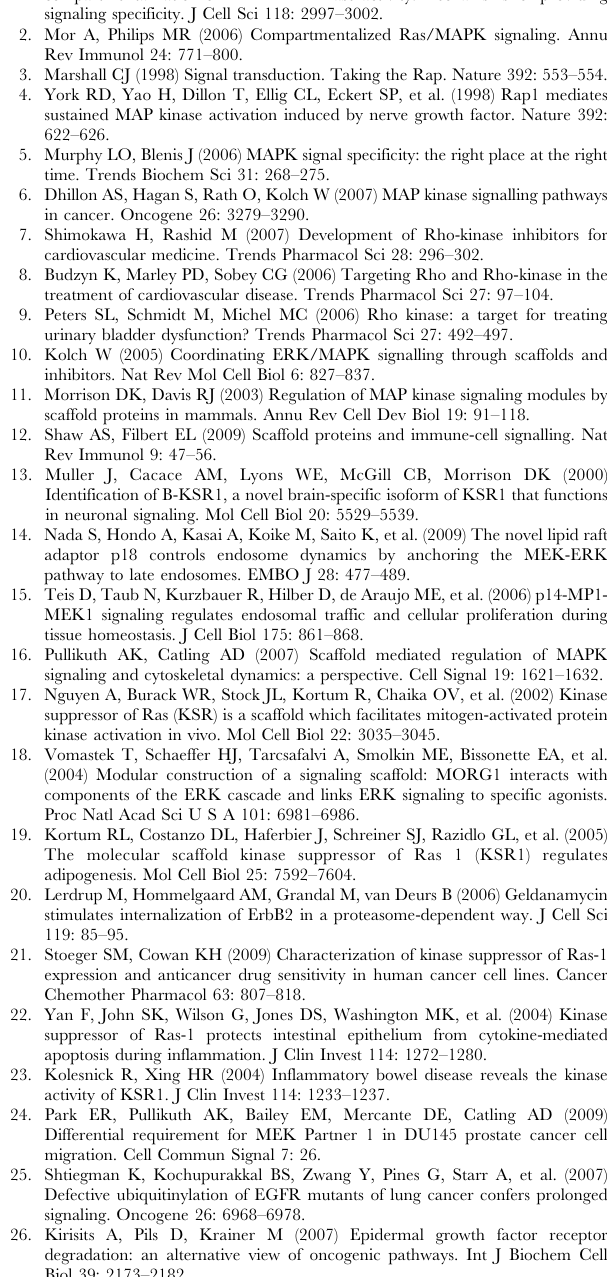
Table S2 List of species and initial concentrations used in the model. (DOC) Text S1 A detailed description of the signaling model used in this study.